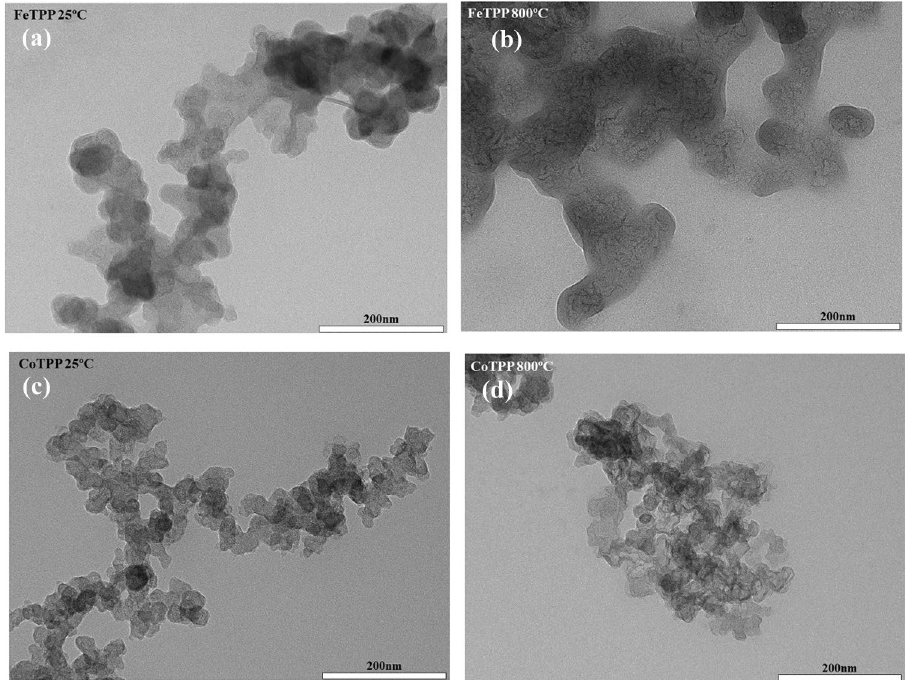
Figure 2. Transmission electron microscopy images of ( a ) FeTPP 25 °C, ( b ) FeTPP 800 °C, ( c ) CoTPP 25 °C, and ( d ) CoTPP 800 °C adsorbed on Vulcan